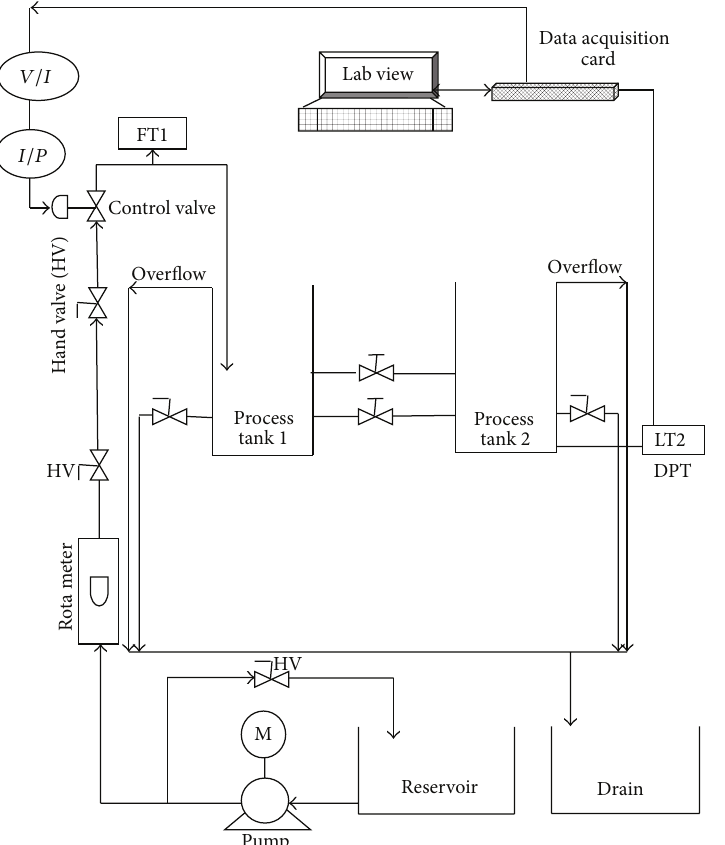
Figure 3: Coupled tank